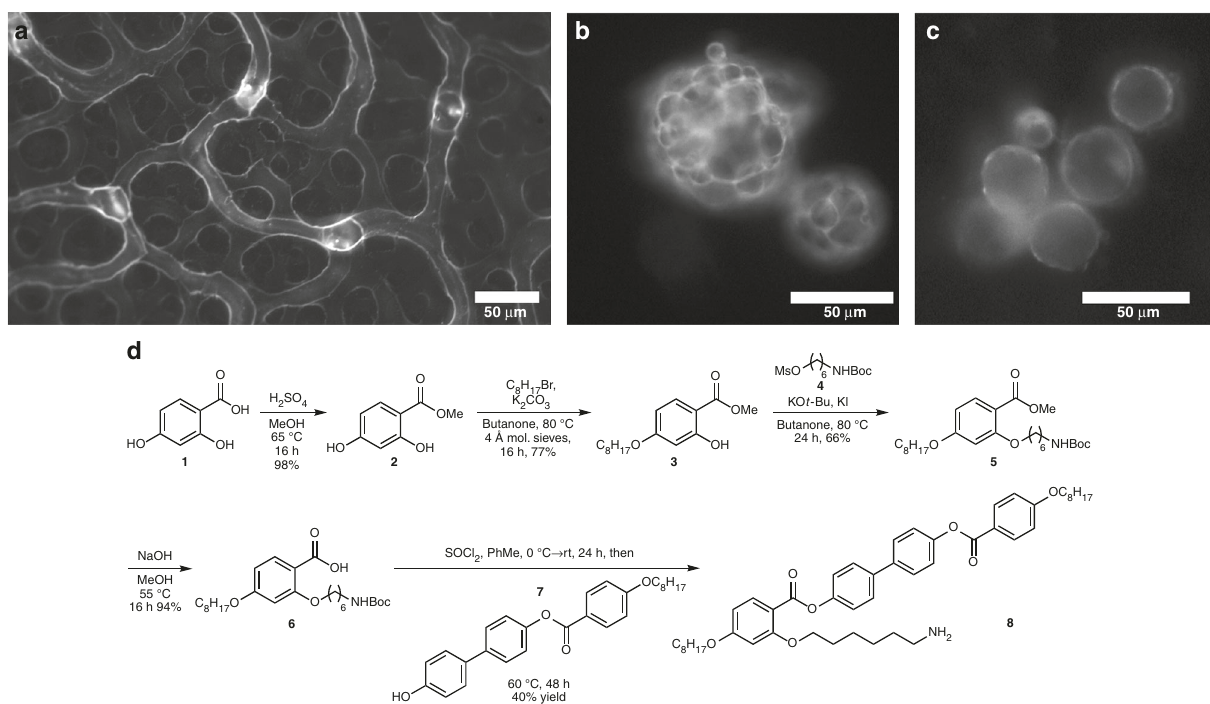
Fig. 1 Hollow nanoparticle-based microstructures formed from ligand-modi fi ed quantum dots. Fluorescence microscopy imaging demonstrates the three distinct quantum dot structures formed under different conditions: a branching tubular network, formed at 1 °C min − 1 , b solid closed-cell foam-like structures formed at 30 °C min − 1 , and c hollow shell capsules formed at 200 °C min − 1 . All structures are composed of 620 nm CdSe/ZnS ligand-modi fi ed quantum dots, suspended in nematic liquid crystal initially at 0.15 wt% at room temperature. d Sequence of reactions used to prepare the mesogenic ligand ( 8 ) for nanoparticle